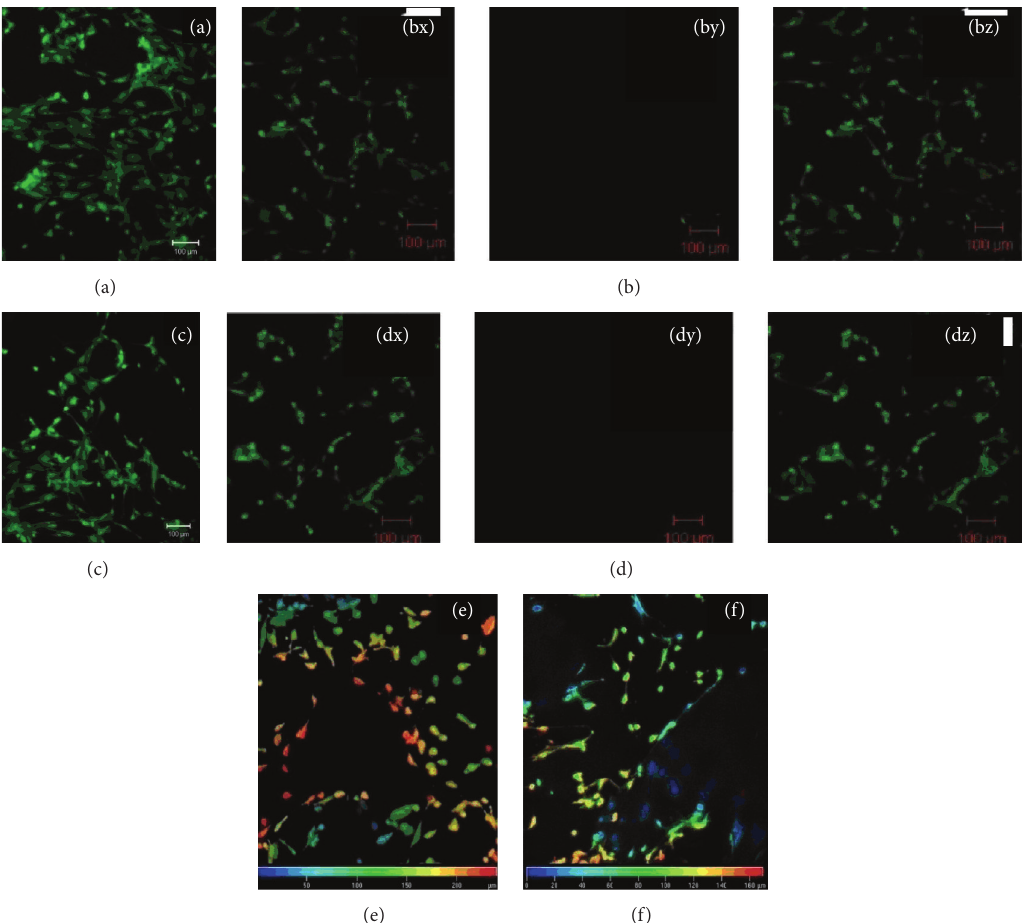
Figure 6: Confocal images showing ADMSCs attachment on device. (a) Porous surface of the material. (bx, by, and bz) Overlay image of live and dead cells on porous surface of the material (c) Dense surface of the material. (dx, dy, and dz) Overlay image of live and dead cells on dense surface of the material (e) Depth code analysis of cell viability on the porous surface. (f) Depth code analysis of cell viability on the dense